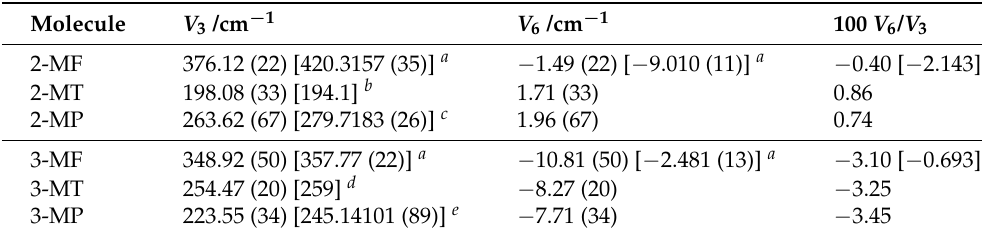
Table 3. V 3 and V 6 barriers for 2- and 3- methylfuran (MF), methylthiophene (MT) and methylpyrrole (MP) calculated with B3LYP/aug-cc-pVTZ as the function of the methyl groups torsional angle α . Uncertainties are the standard error given by Gnuplot [24] for the fit of the DFT potential based on Equation (5). The experimental values determined in this work for MF or in the literature for MT and MP are mentioned in square